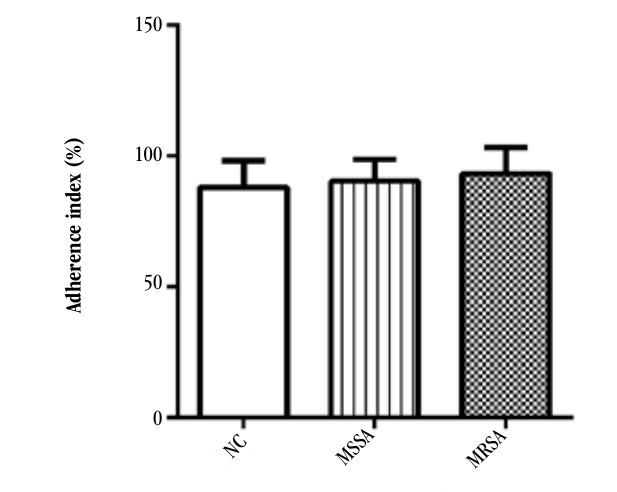
figurE 1 – AI of alveolar macrophages from adult Wistar rats for the following systems: NC, MSSA and MRSA. Values expressed as mean ± standard error ( n = 20) AI: adhesion index; NC: negative control; MSSA: methicillin sensitive S. aureus ; MRSA: methicillin resistant S. aureus .